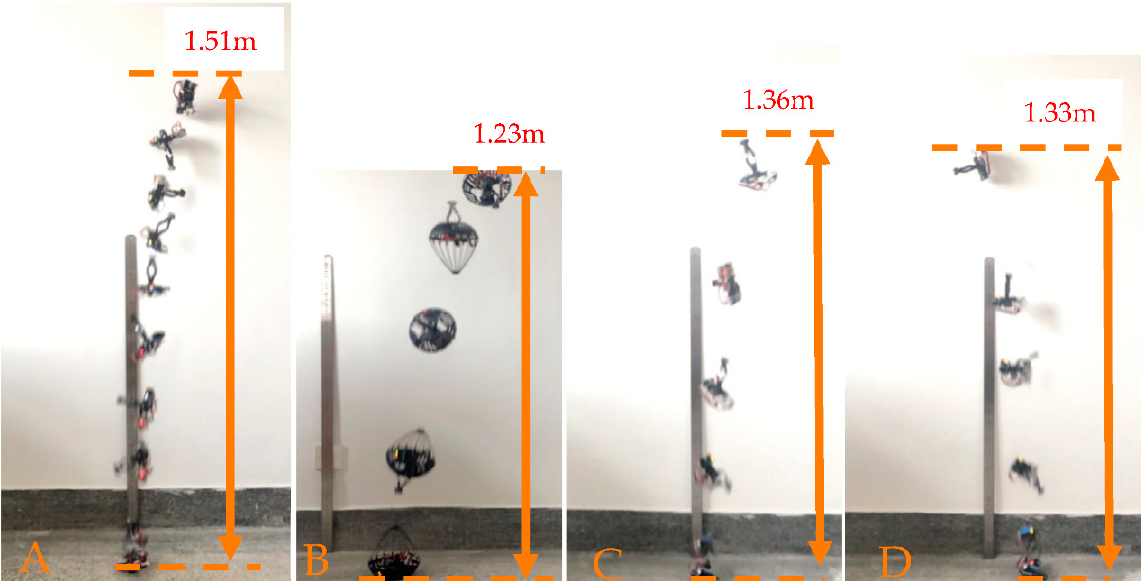
Figure 8. Testing the jumping height of the jumping mechanism for different load levels and different amounts of energy storage. ( A ) The storage energy was the largest (2.9 J) and the load in the bouncing mechanism was 98.6 g. ( B ) The storage energy was the largest (2.9 J) and the load in the whole robot was 156.8 g. ( C ) The storage energy was the largest (2.9 J), where the load in the bouncing mechanism was 98.6 g and extra mass of 30 g was used. ( D ) The storage energy was not full (2.1 J) and the load in the bouncing mechanism was 98.6 g.